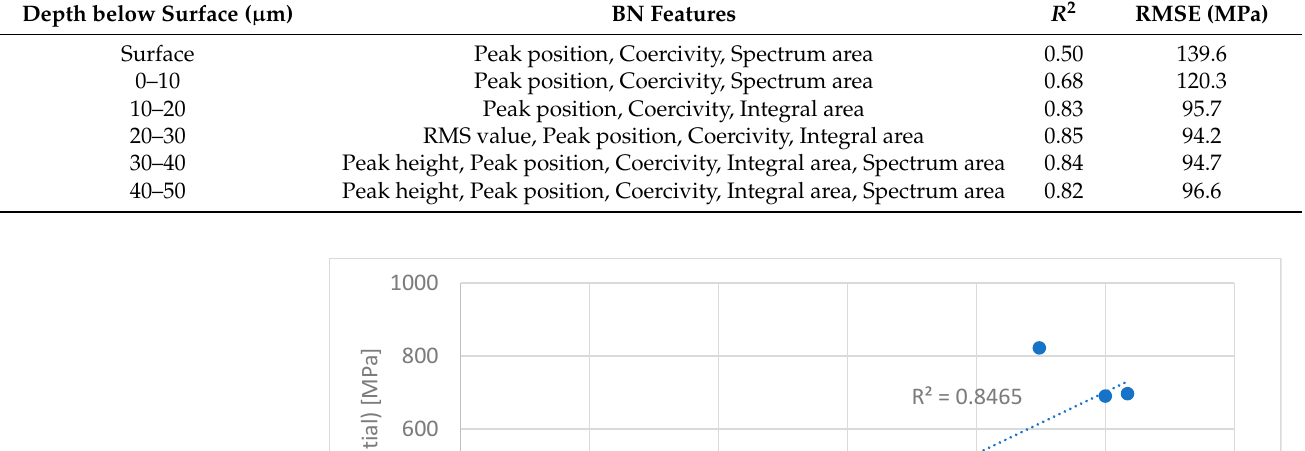
Table 1. Models obtained for estimating averaged residual stresses.